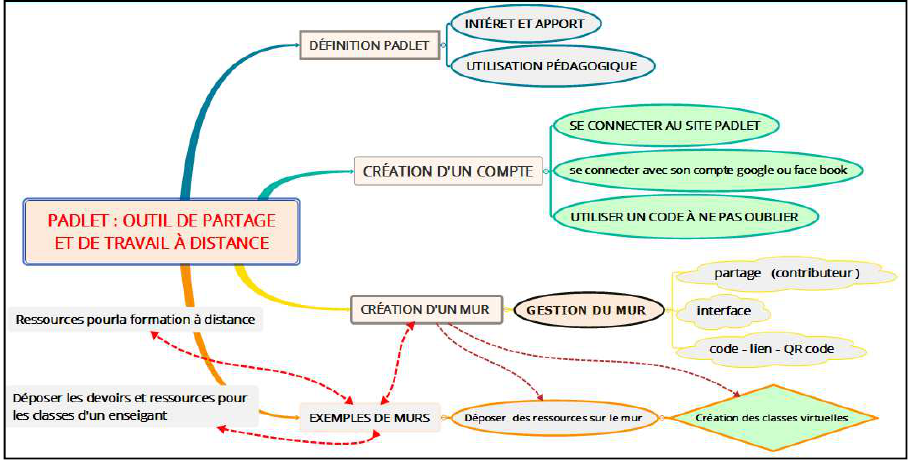
Fig. 9. Carte conceptuelle de la gestion du logiciel